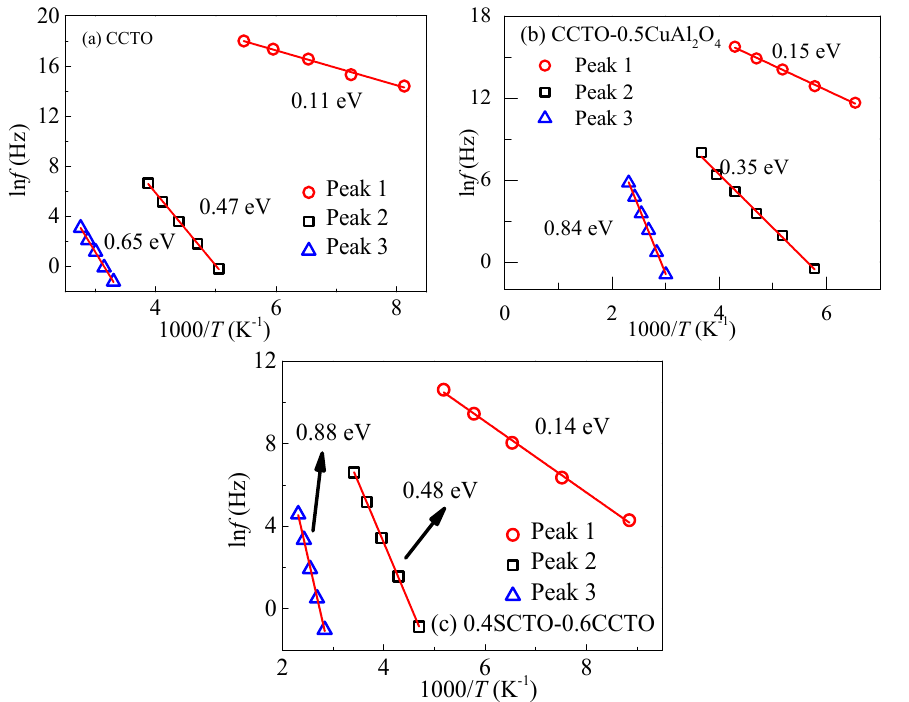
Figure 6. Frequency dependence of the electric modulus in the temperature range of 153–433 K for undoped CCTO ceramics ( a ), CaCu 3 Ti 4 O 12 /CuAl 2 O 4 composite ( b ) and 0.4SCTO-0.6CCTO ( c ).